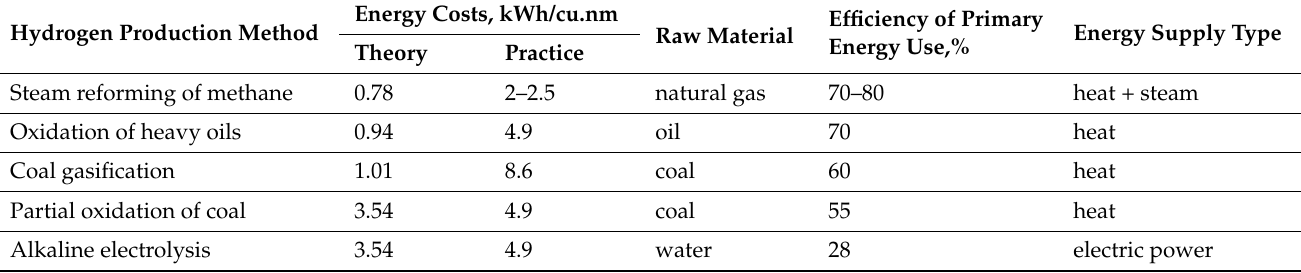
Table 2. Description of the main methods for producing